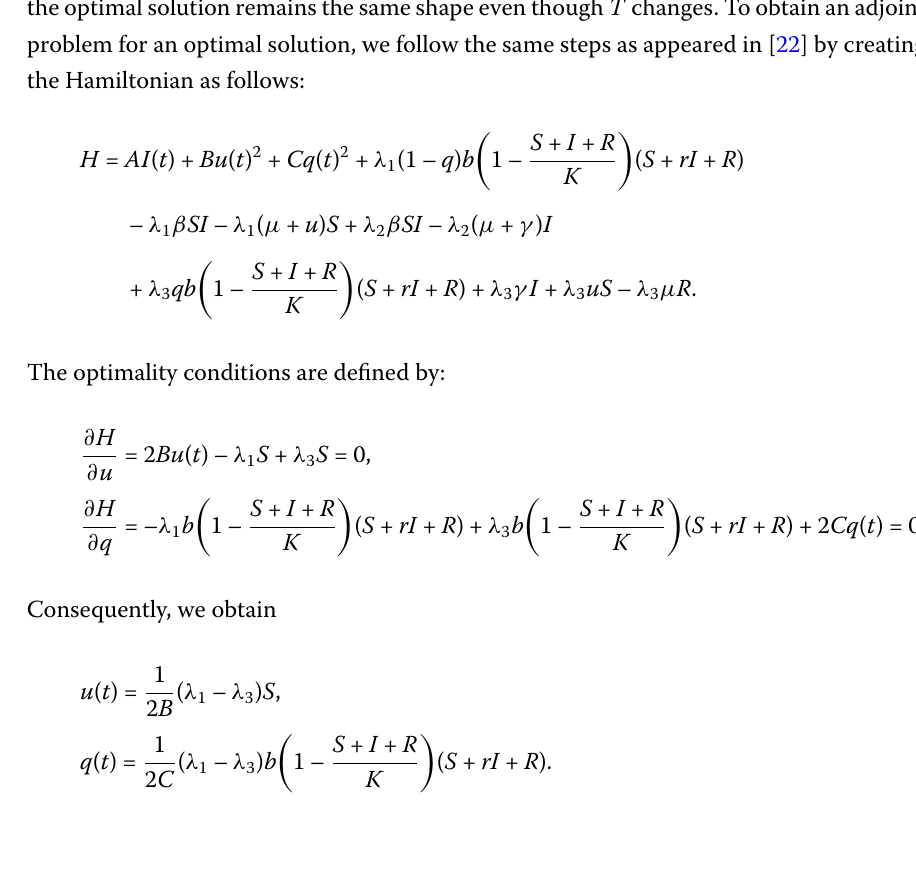
The time domain is chosen to be 2 years in this study, t ∈ [0, T ] = [0,2]. The